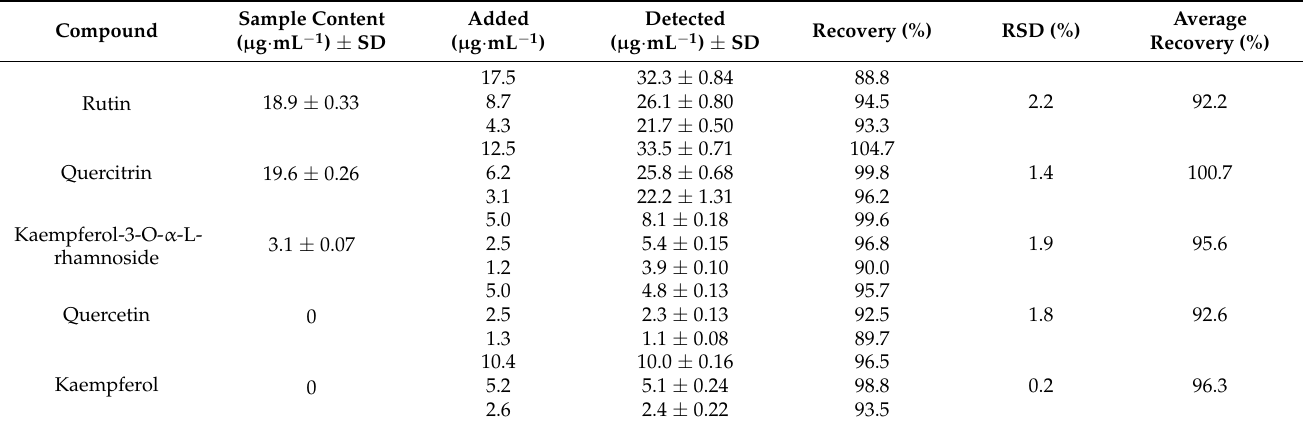
Table 2. Recovery results of five flavonoids ( n = 3).